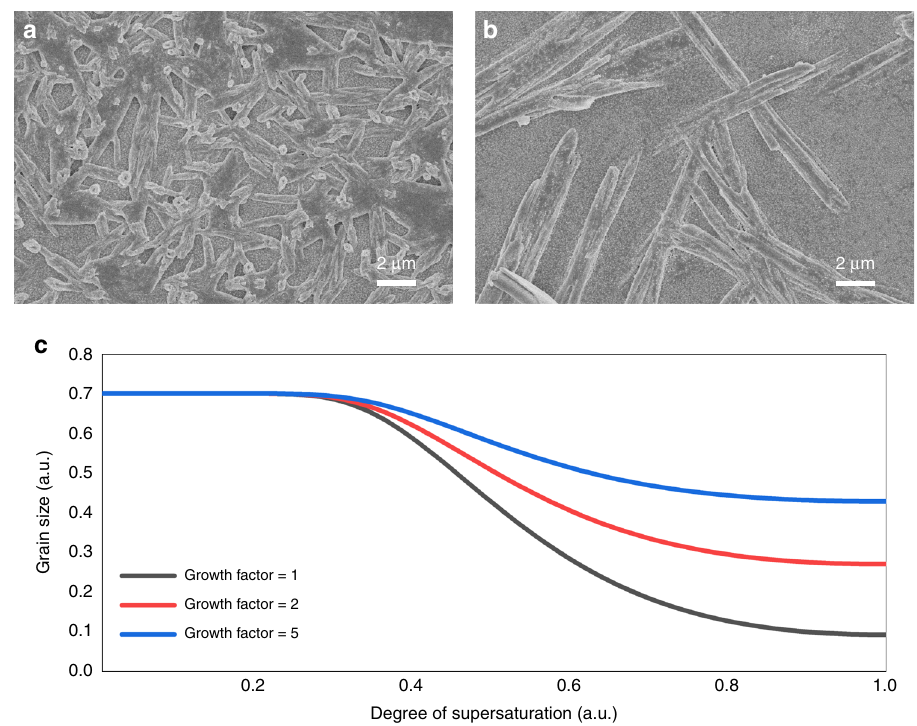
Fig. 2 The intermediate formation in dry air and in ambient atmosphere. The scanning electron microscope (SEM) image of the MA 2 Pb 3 I 8 ·2DMSO intermediate in a glove box and b ambient atmosphere without the antisolvent dripping step (spinning at 6000 r.p.m. for 2 min and annealing at 98 °C for 1 min). The rods in the sample fabricated in ambient atmosphere have a lower density but a larger size than that fabricated in glove box. c The simulated crystal size as a function of the supersaturation degree, with different growth factors. In general, the crystal size decreases as the growth factor decreases or as the supersaturation degree increases. A larger growth factor means that the growth rate increases more than the nucleation rate, when the crystallization condition is